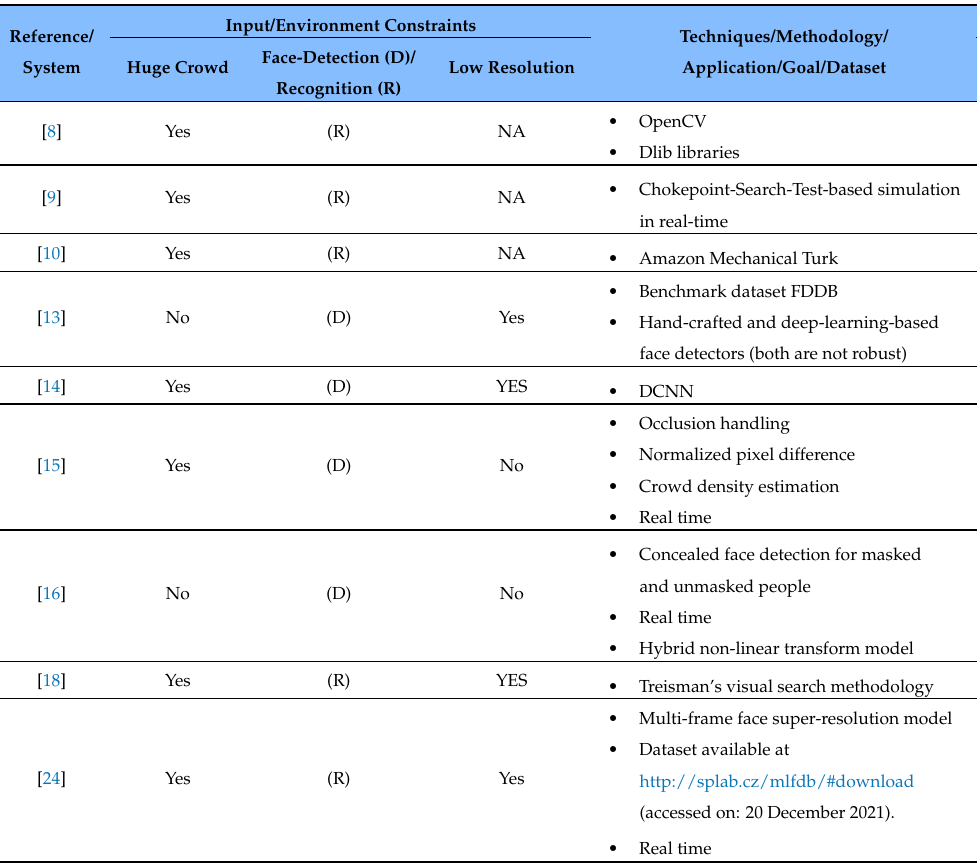
Table 1. Comparison of related work-based selected